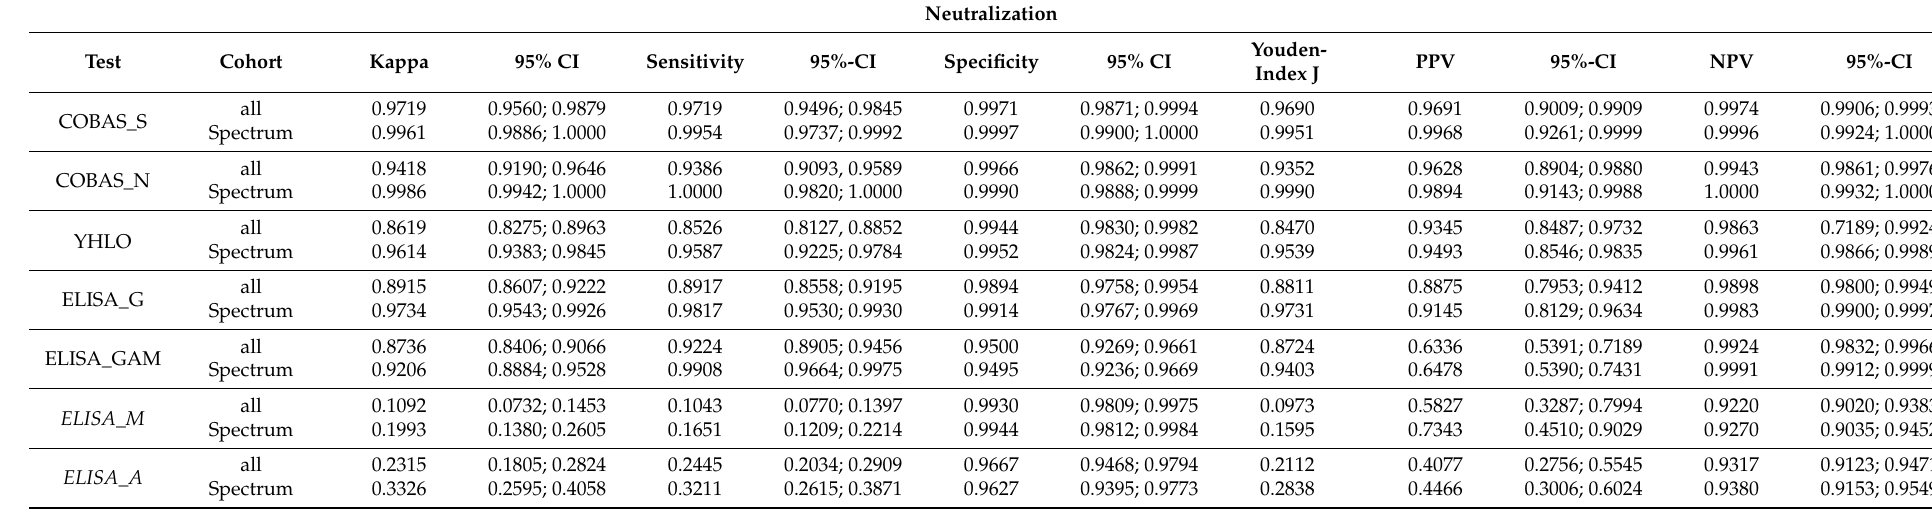
Table 3. Relationship between dichotomized antibody test results and dichotomized neutralization results. For each antibody test Cohen’s kappa, sensitivity, specificity, positive predictive values (PPV), negative predictive values (NPV) and accompanying 95%-CIs as well as the Youden-Index, are shown for the complete subgroup ( n = 856 weighted to n = 4185) in the corresponding first row (labelled “all”) and for the reduced subgroup ( n = 615 weighted to n = 4185) representing the test establishment setting (only participants with neutralization IC-50 < 1 or >100 included) in the second row labelled “Spectrum” (corresponding groups are highlighted by the same